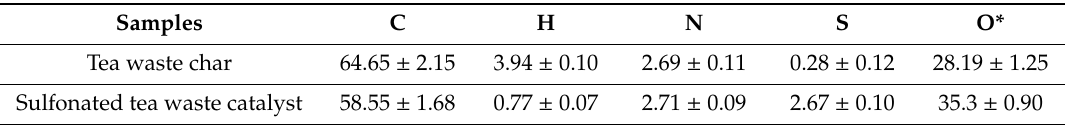
Table 2. Elemental composition of tea waste (TW) char and synthesized sulfonated tea waste (STW) catalyst.